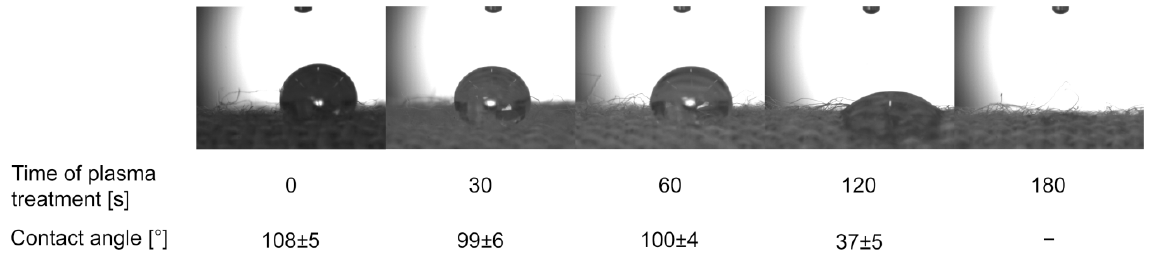
Figure 2: Water contact angle of raw and plasma treated linen fabrics as a function of time of plasma